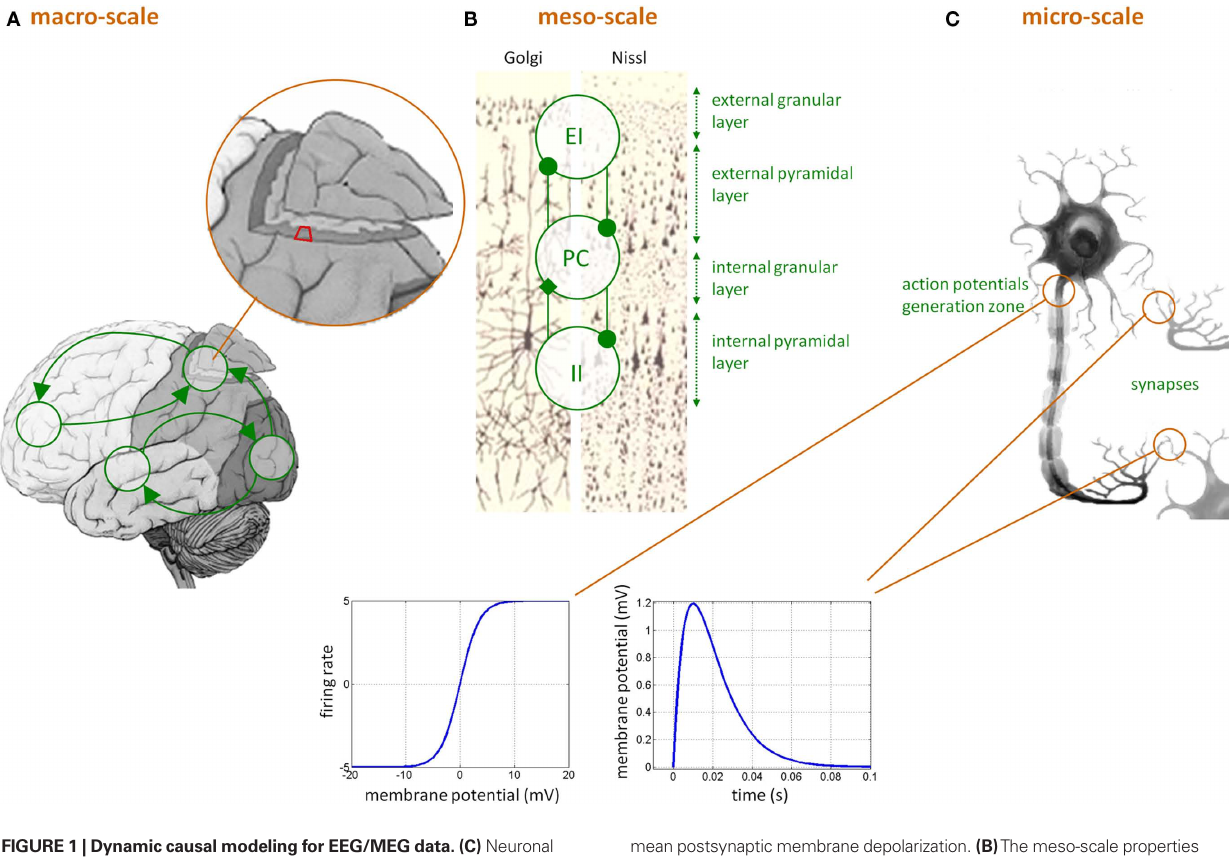
mean postsynaptic membrane depolarization. (B) The meso-scale properties that affect the macro-scale (A) , i.e., within-region invariant connectivity structure between pyramidal cells (PC), excitatory interneurons (EI), and inhibitory interneurons (II) subpopulations across cortical layers. (A) The macro-scale effective connectivity